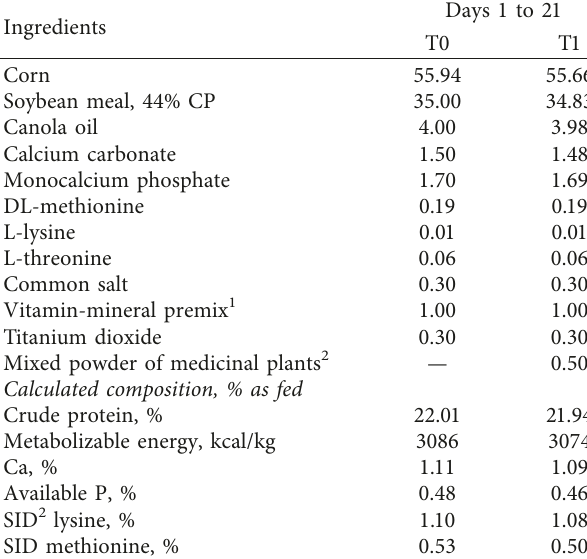
Table 1: Composition and nutrient content.